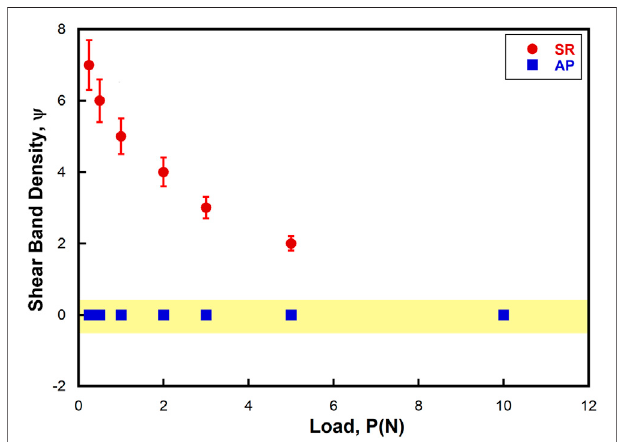
FIGURE 9 | Variation of free volume with maximum indentation load, P max , for AP and SR